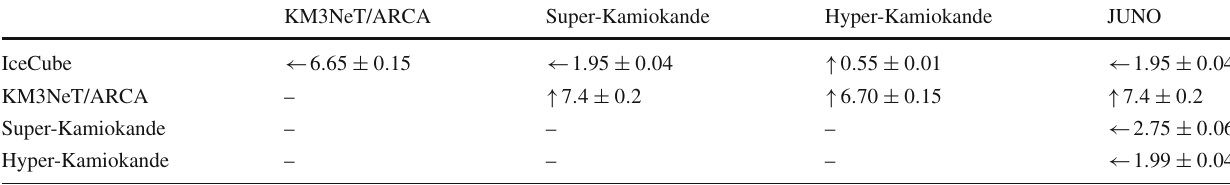
Table 3 Uncertainty δ t in milliseconds obtained with the chi-square method using average background subtraction and unity normalization of the detector neutrino light-curves. The detector pairs are listed in row